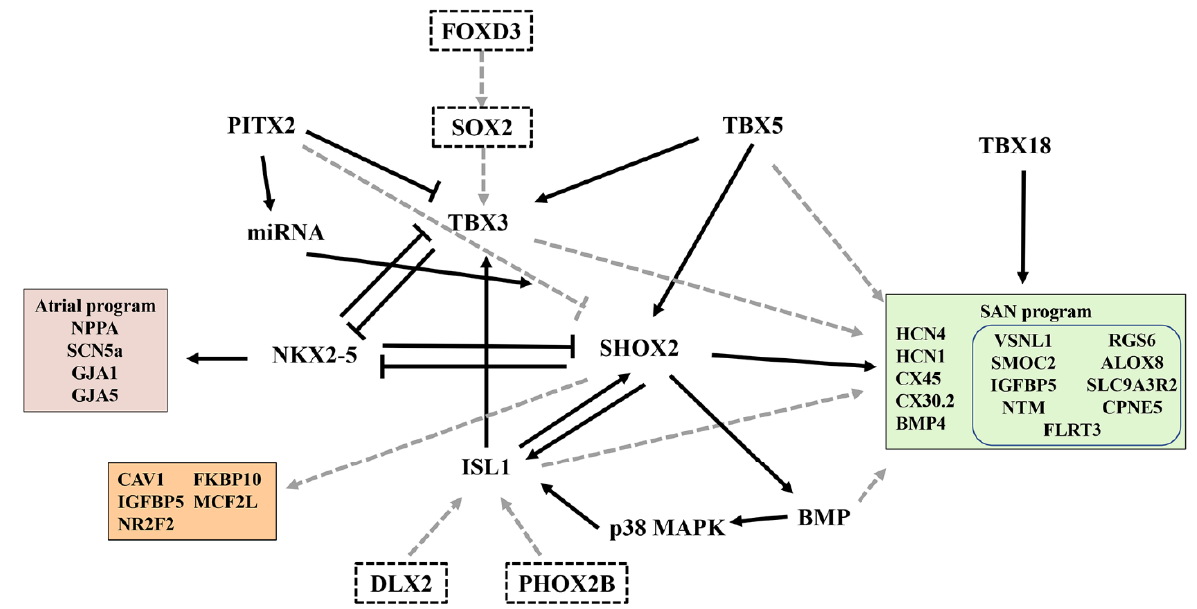
Figure 2. A gene regulatory network that controls SAN development and function. The black arrows indicate gene activation. Black lines with blunt ends represent the inhibition of gene expression by their corresponding transcription factors. The dotted lines indicate indirect or speculation effects. The right box represents the SAN program, and the blue box indicates the SAN-related gene discovered by single-cell sequencing. The left upper box represents the atrial program; the left lower box indicates the genes regulated by SHOX2 . The dotted box indicates the potential transcription factors associated with the SAN.